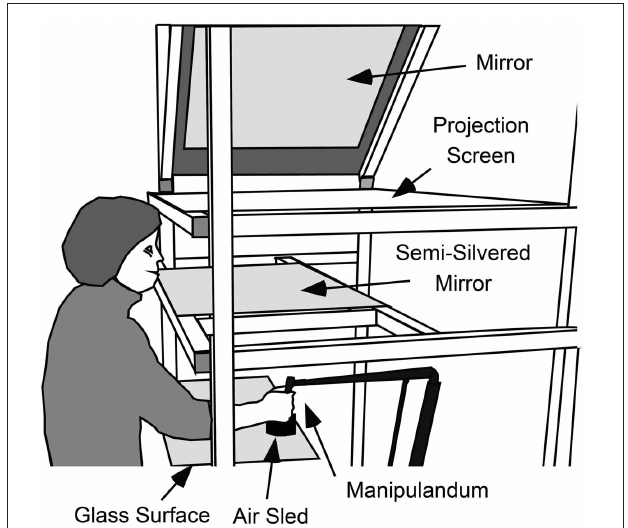
FIGURE 1 | Apparatus used to measure gaze and hand movements and to present visual feedback about targets and cursor position. While seated, participants used their right hand to grasp the handle of a light-weight manipulandum that measured the position of the hand in three-dimensions. The handle of the manipulandum was supported by an “air-sled” that rode across a horizontal glass surface on a cushion of air. With this support, the hand was effectively constrained to move in a horizontal plane. A video projector (not shown), above and to the right of the participant, projected targets, and cursor onto a projection screen via a 45 ◦ mirror. Participants viewed the cursor targets in a semi-silvered mirror located halfway between the projection screen and the plane of hand movement and could not see their hand. Thus, the targets and cursor appeared in the same plane as the